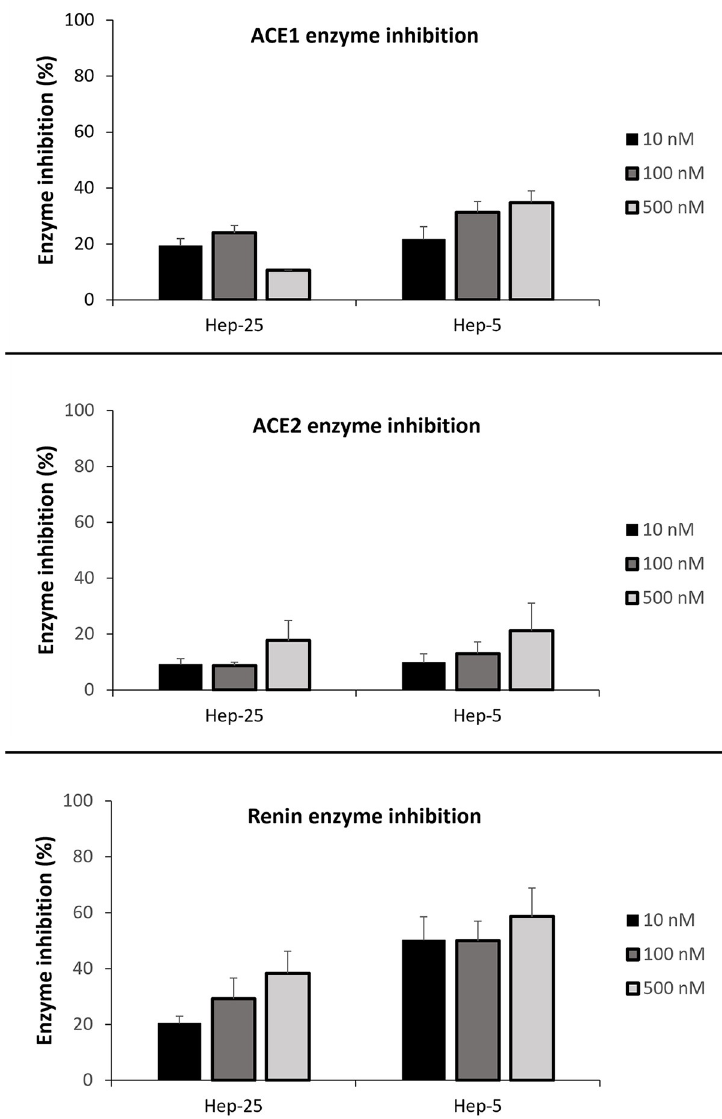
Fig 3. Inhibitory effects of hepcidin-25 and hepcidin-5 on the ACE1, ACE2 and renin with the standard errors of mean (SEM). Fluorometric enzyme inhibition analysis was measured with peptide concentrations 10, 100 and 500 nM. Hepcidin peptides had the highest inhibitory effect on renin. Number of experiments for concentrations 10 nM, 100 nM and 500 nM, respectively. ACE1 and hepcidin-25: 5-6-1. ACE1 and hepcidin-5: 4-6-6. ACE2 and hepcidin-25: 3-6-4. ACE2 and hepcidin-5: 3-6-3. Renin and hepcidin-25: 2-3-3. Renin and hepcidin-5: